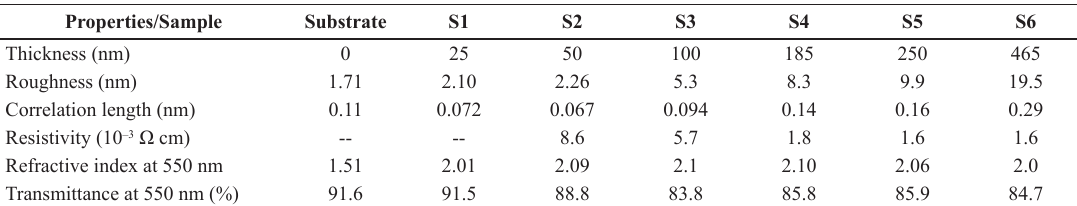
Table 1. Structural, electrical and optical properties of the ZnO:Al thin films as a function of the thickness. Properties/Sample